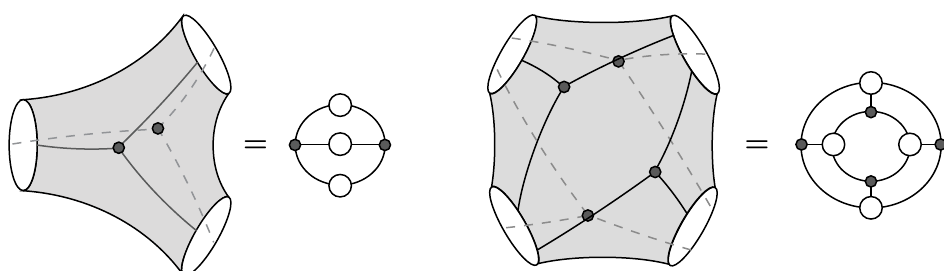
Figure 25 . (Metric) ribbon graph from a triangulation of (cid:6) 0 ; 3 and (cid:6) 0 ; 4 .